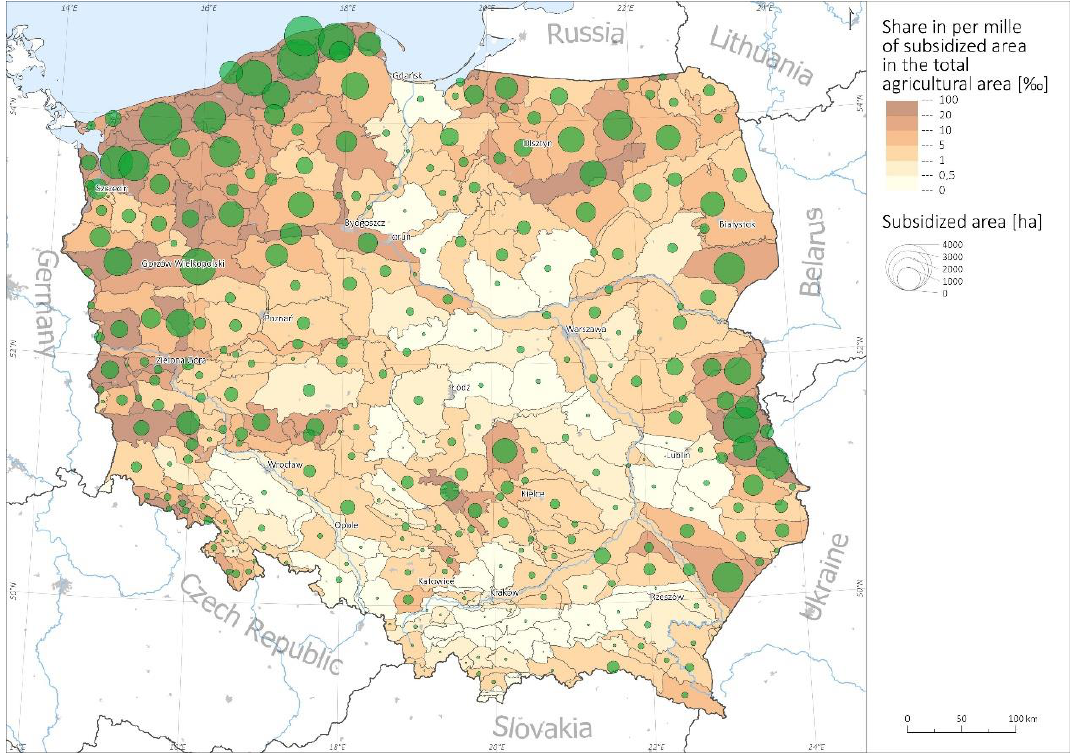
Figure 6. Area of land subsidised to support the protection of semi-natural wet meadows and their share in the total area of agricultural land in mesoregions (Source: Authors based on ARMA data).